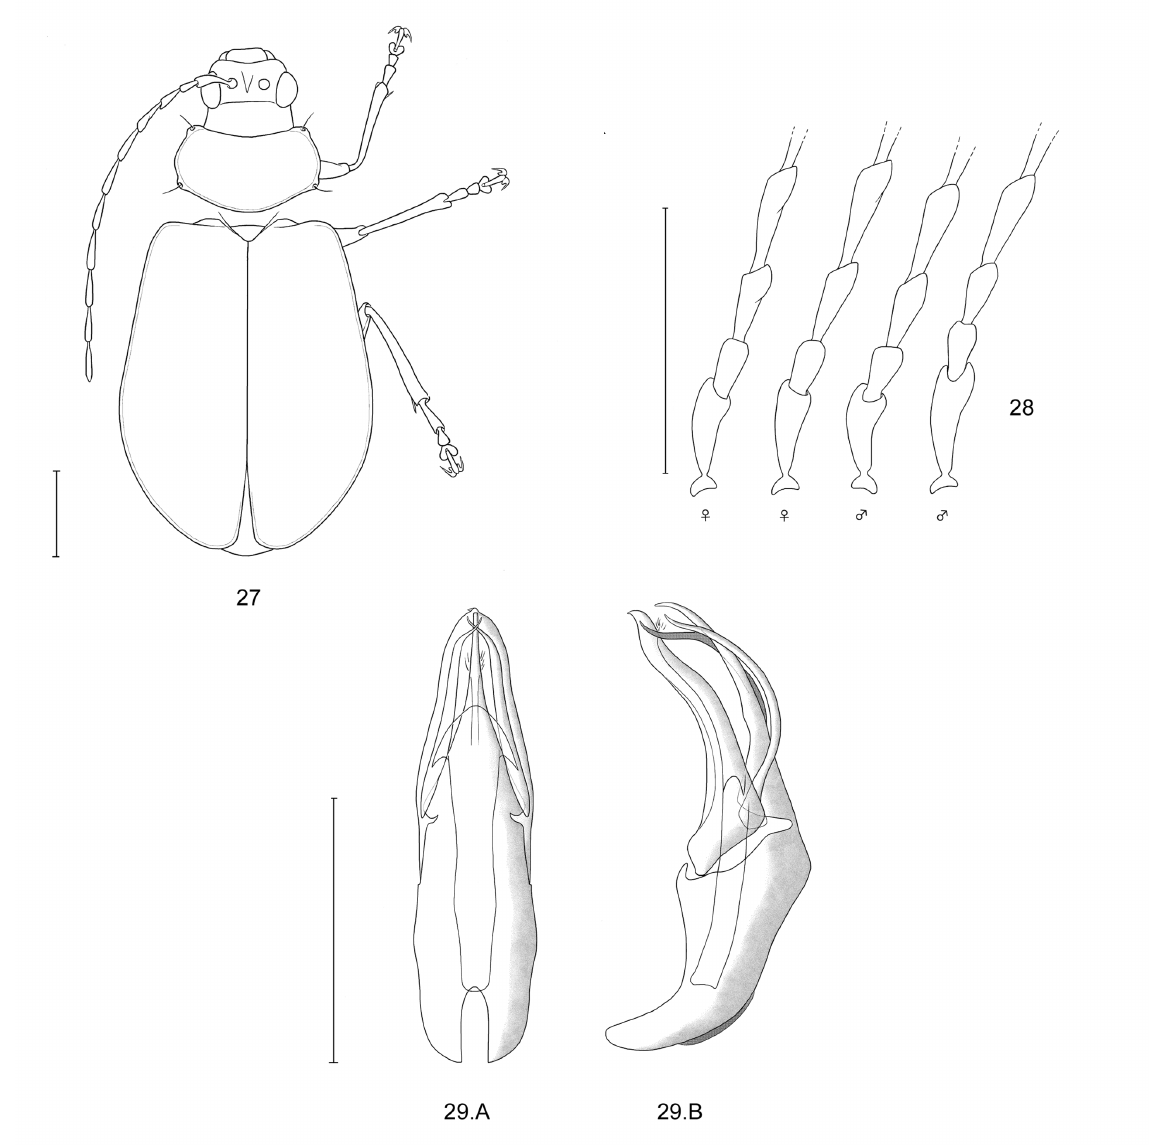
Figs 27-29. Oosagitta melanopicta sp. nov. 27 . Habitus, semi-schematic dorsal view. 28. Basal four antennomeres of 2 ♂♂ and 2 ♀♀. 29 . Median lobe. A . Dorsal. B . Lateral. Scale bars: 1